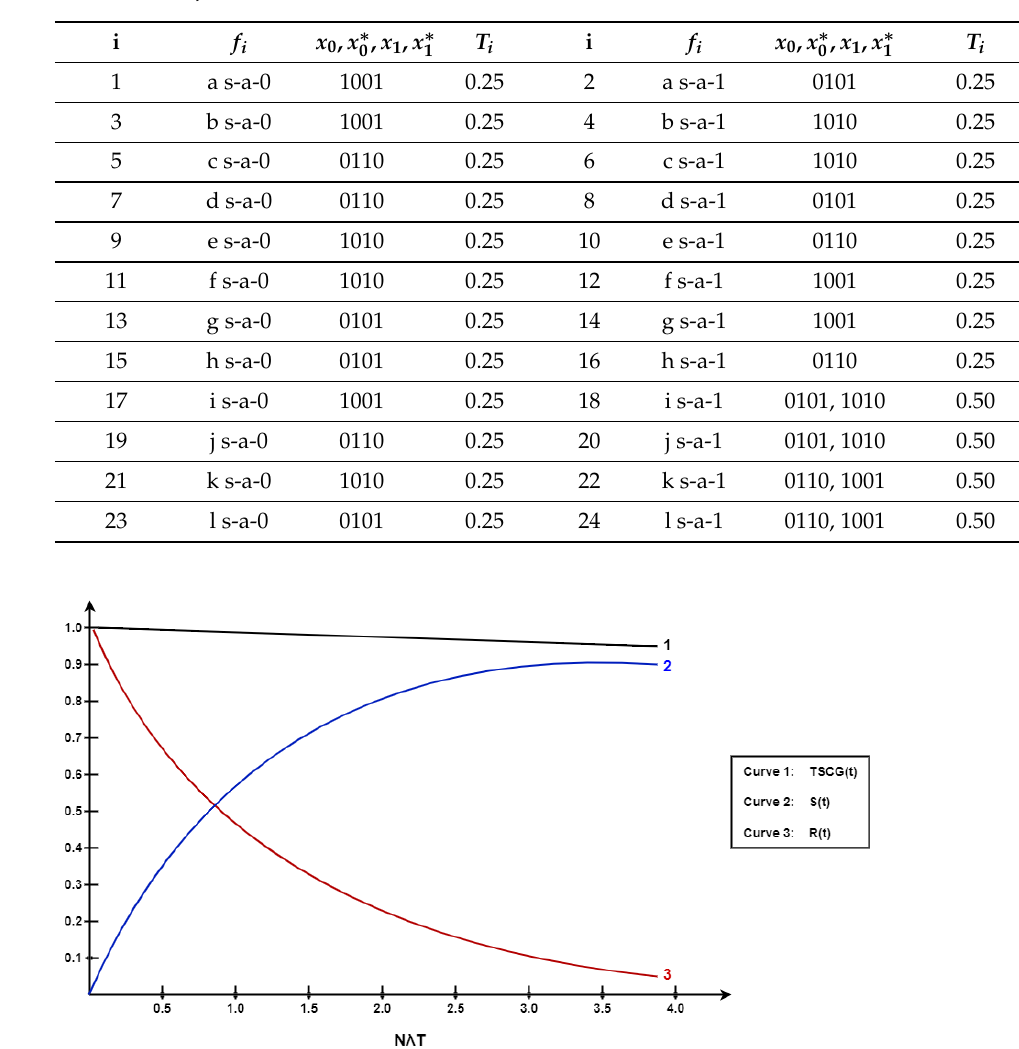
Table 1. The T i s of the TSC two-rail checker’s nodes.